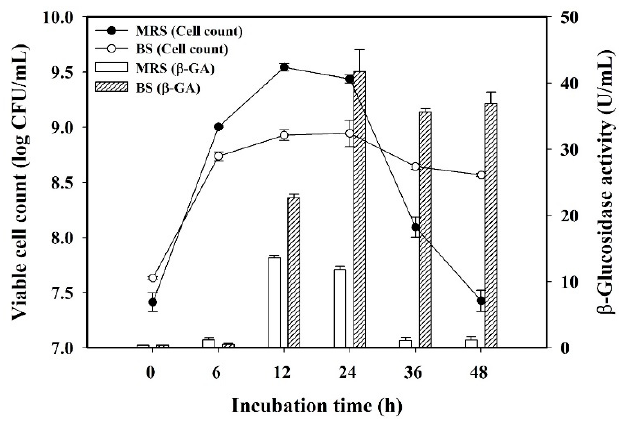
Figure 1. Variations of viable cell count and β -glucosidase activity ( β -GA) of L. plantarum BCRC 10357 in MRS broth and black soymilk (BS) at 37 °C during 48 h of incubation. Data were expressed 10357 in MRS broth and black soymilk (BS) at 37 ◦ C during 48 h of incubation. Data were expressed as mean ± standard deviation with triplicate experiment ( n = 3). as mean ± standard deviation with triplicate experiment ( n =